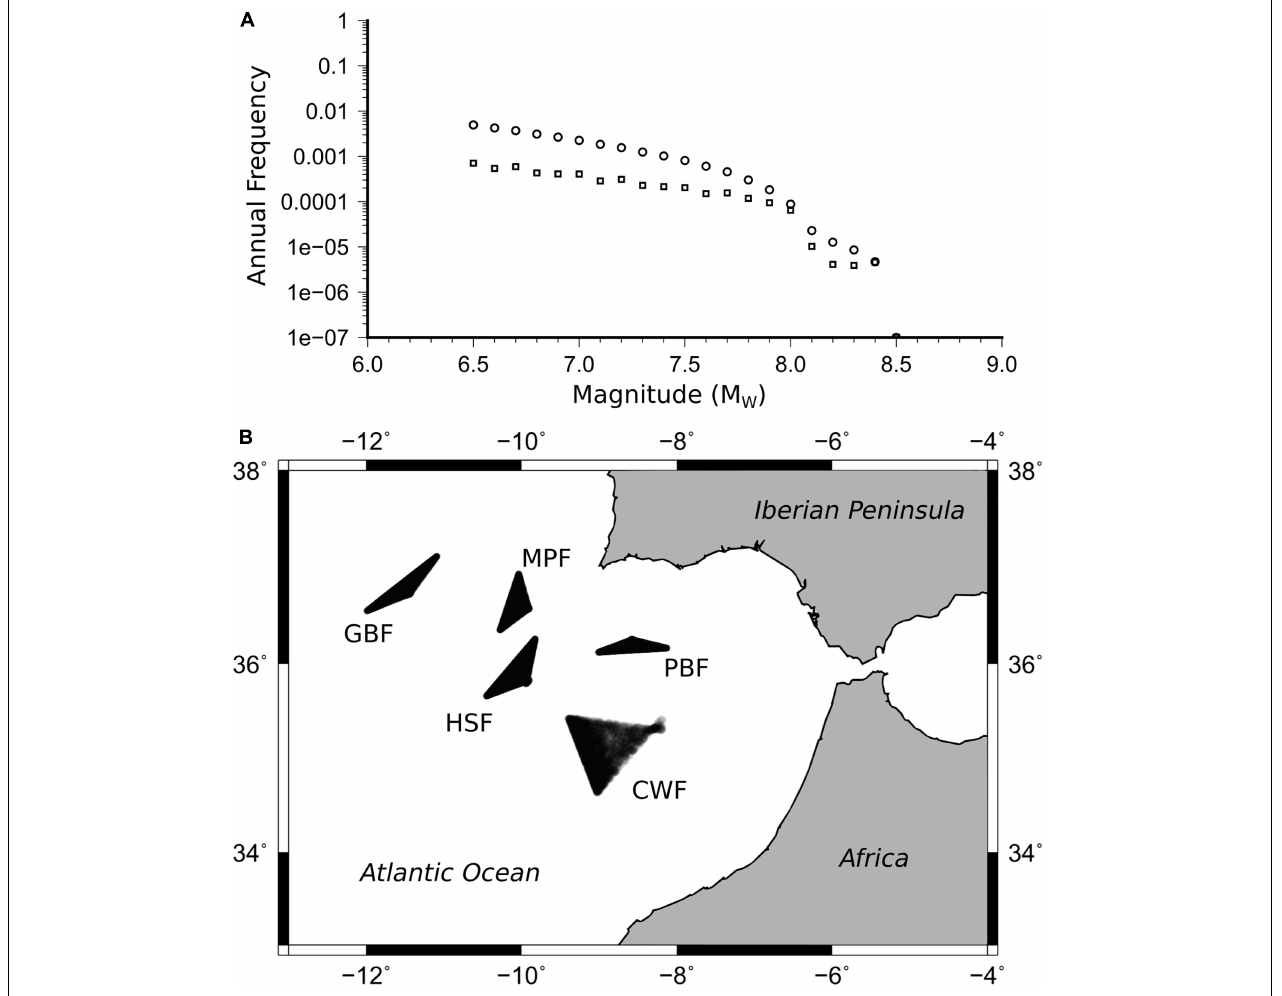
FIGURE 8 | (A) Distribution of all synthetic generated magnitudes M w in discrete (squares) and cumulative(circles) form, and (B) location of the synthetically generated epicenters for all the tsunamigenic earthquake scenarios.